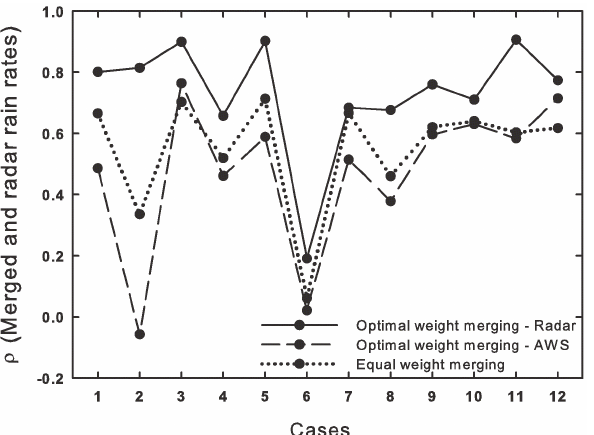
Figure 10. The correlation coefficients between the merged precip- itation and radar rain rate estimation over the different gap areas. The merged precipitation estimates are obtained from the merging methods of optimal weight using radar (solid line), optimal weight using AWS (dashed line), and equal weight (dotted